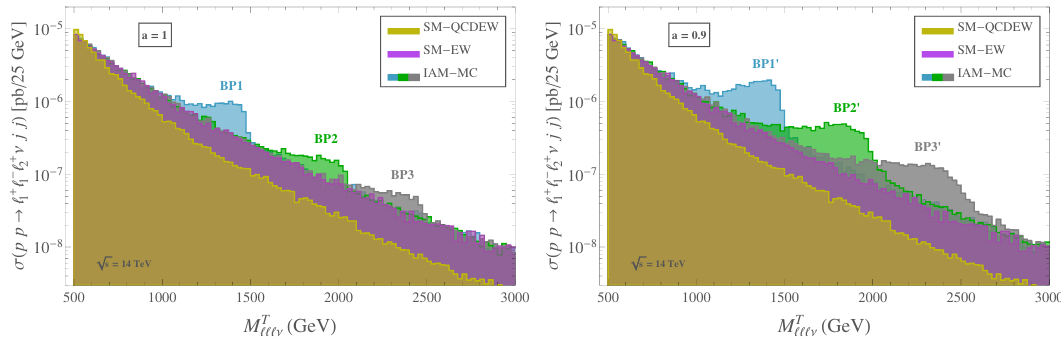
Figure 16 . Predictions of the (cid:27) ( pp ‘ + ‘ (cid:0) ‘ + (cid:23)jj ) distributions with the transverse invariant 1 1 2 ! mass, M T , for the selected benchmark points of the IAM-MC model BP1 (blue), BP2 (green), ‘‘‘(cid:23) BP3 (gray) in the left panel and BP1’ (blue), BP2’ (green), BP3’ (gray) in the right panel, and for the two main SM backgrounds, SM-QCDEW (yellow) and SM-EW (purple). The cuts in eq. (5.5) have been